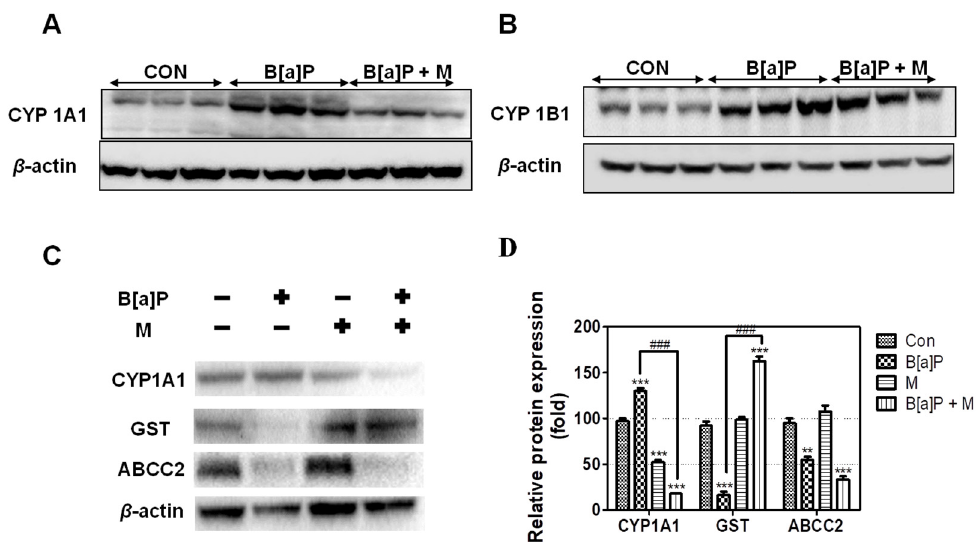
Figure 5. The expression of phase detoxifying enzymes. ( A,B ) The effect of myricetin (15 mg/kg) and B[a]P (2 mg/kg) treatment on CYP1A1 and CYP1B1 enzyme expression in the liver of Sprague-Dawley rats. ( C ) The effect of myricetin (10 μ M) and B[a]P (10 μ M) treatment on CYP1A1, GST, and ABCC2 enzyme expression in HepG2 cells. ( D ) Quantitative evaluation of relative protein expression of CYP1A1, GST, and ABCC2. All treatment groups are significantly different when compared with controls (** p < 0.01, *** p < 0.001) and B[a]P (### p < 0.001). Tukey’s multiple comparison test. M: myricetin.